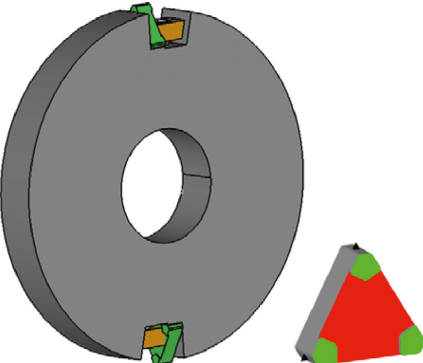
Figure 1: Single point diamond cutting tool and clamping device.